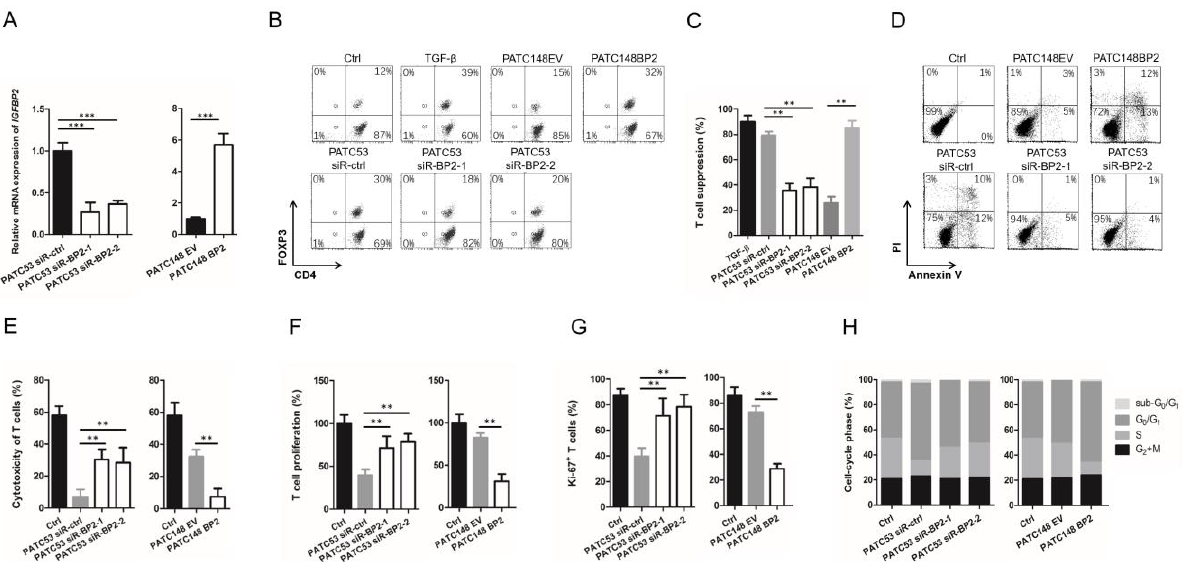
Figure 3. IGFBP2 alters T cell differentiation to promote an immunosuppressive phenotype. ( A ) Relative IGFBP2 mRNA expression levels of different PDAC cell lines were assessed by qRT-PCR, normalized to GAPDH (*** p < 0.001 by ANOVA for PATC53 or the Student’s t -test for PTAC148). ( B ) Flow cytometry analysis of human CD4 + T cells cultured without or with TGF- β , or co-cultured with PDAC cells with differential expression of IGFBP2 for CD4 + FOXP3 + Tregs. ( C ) Activated CD8 + T cells were co-cultured with the Tregs inducted by TGF- β or PDAC cell lines to verify their T cell suppressive function (** p < 0.01 by ANOVA for PATC53 or the Student’s t -test for PTAC148). ( D ) Human CD8 + T cells co-cultured with PDAC cells with differential expression of IGFBP2 assessed flow-cytometrically for apoptotic CD8 + T cells. ( E – H ) Cytotoxicity, proliferation, Ki-67, and cell cycle analyses were performed on the same CD8 + T cells described in ( D ) (** p < 0.01 by ANOVA for PATC53 or the Student’s t -test for PTAC148). Data are mean ± SD from 3 or more assays performed independently.